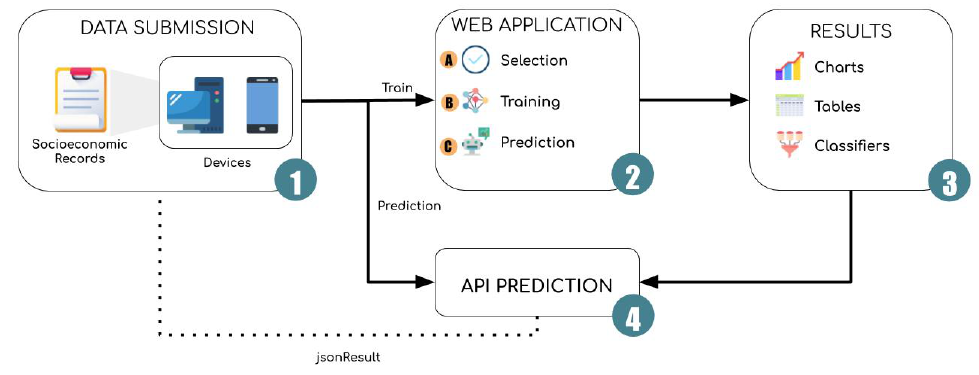
Figure 2. Overview of the socioeconomic records processing in the Internet of Things (IoT)